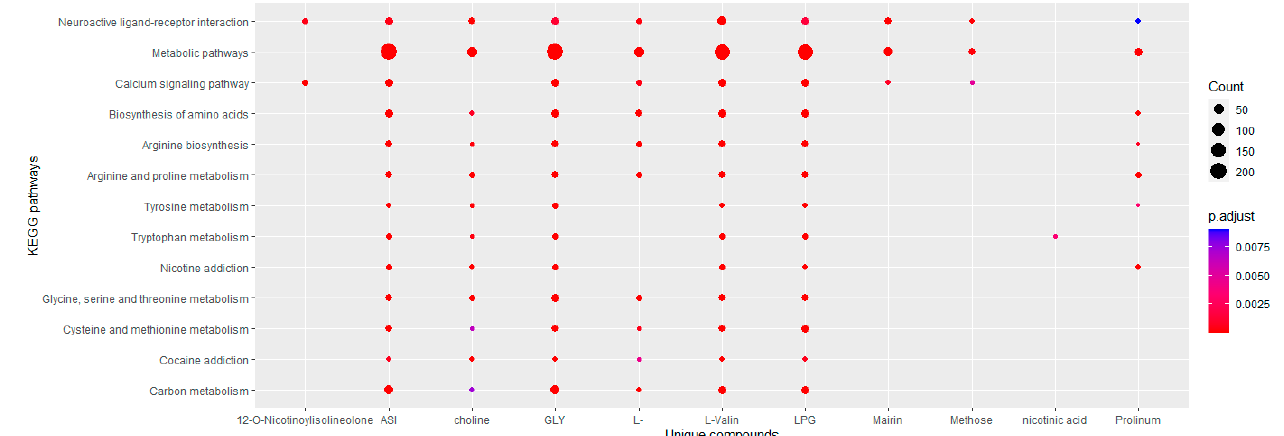
Figure 3. Top main KEGG pathways of unique compounds of Qi-invigorating herbs. LPG, L-alanine; GLY, glycine; ASI, aspartic acid; L-, L-arginine. To interpret the relationships between QIHs and their unique compounds and path-